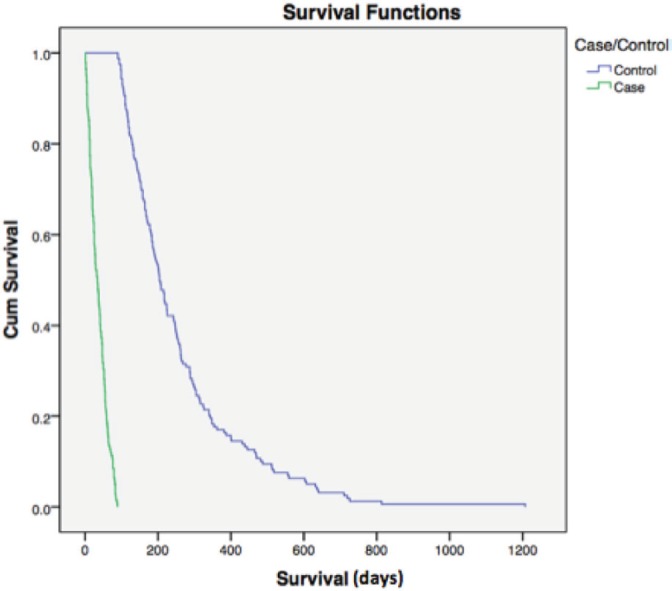
Overall survival case versus controls. Median overall survival was 34 and 204 days among cases and controls, respectively (HR = 0.177; 95% CI = 0.015–0.033, p < 0.0001). Cum = cumulative.